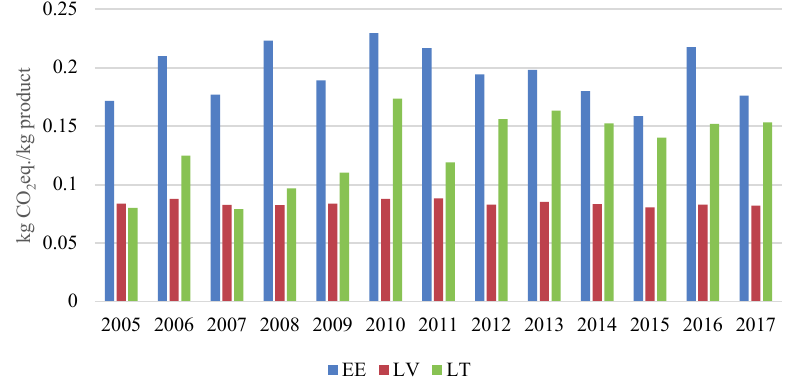
Fig. 2. GHG emission intensity